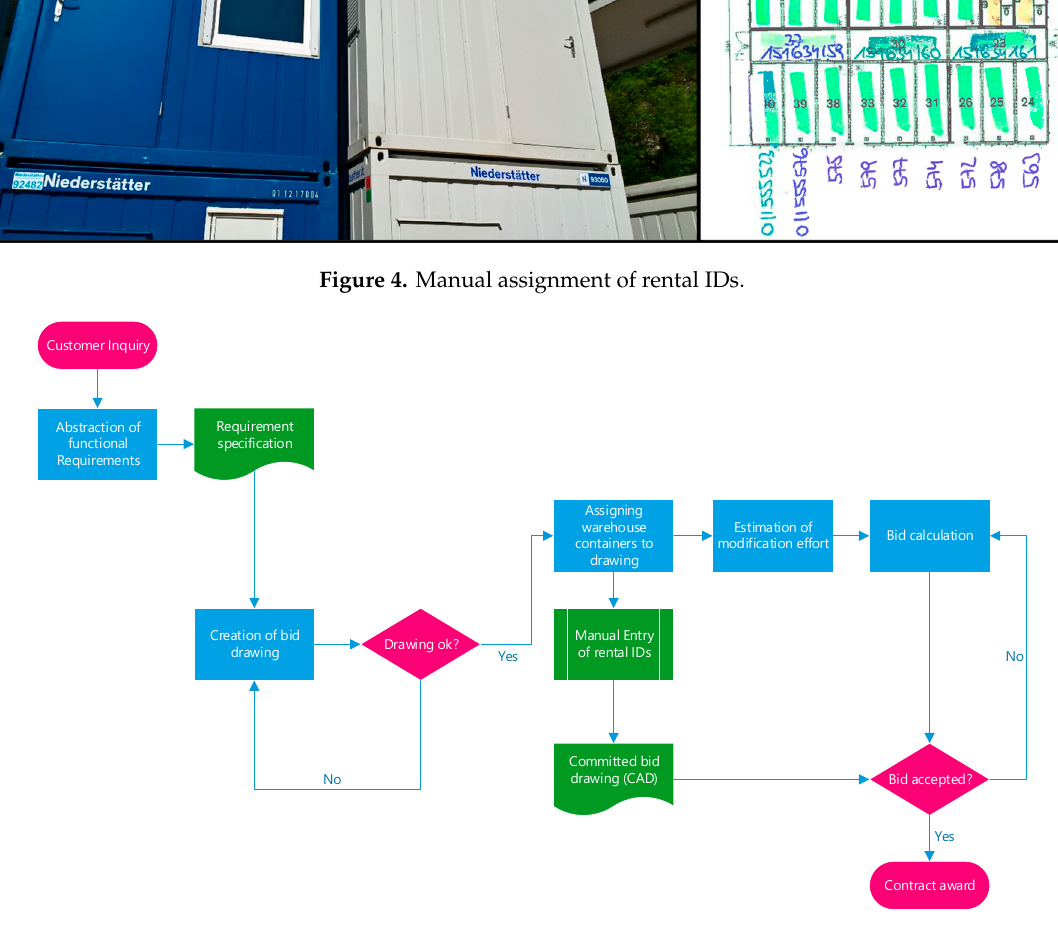
Figure 5. Current overall process.